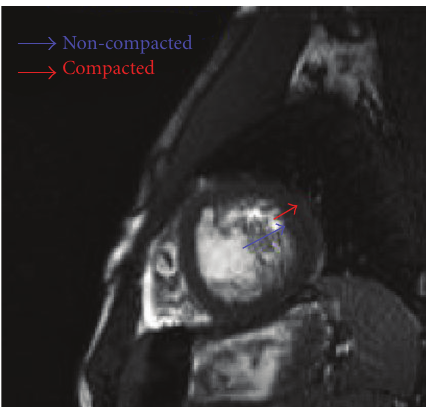
Figure 3: CMR measurements of the compacted (8mm) and non- compacted (21 mm) layers of the